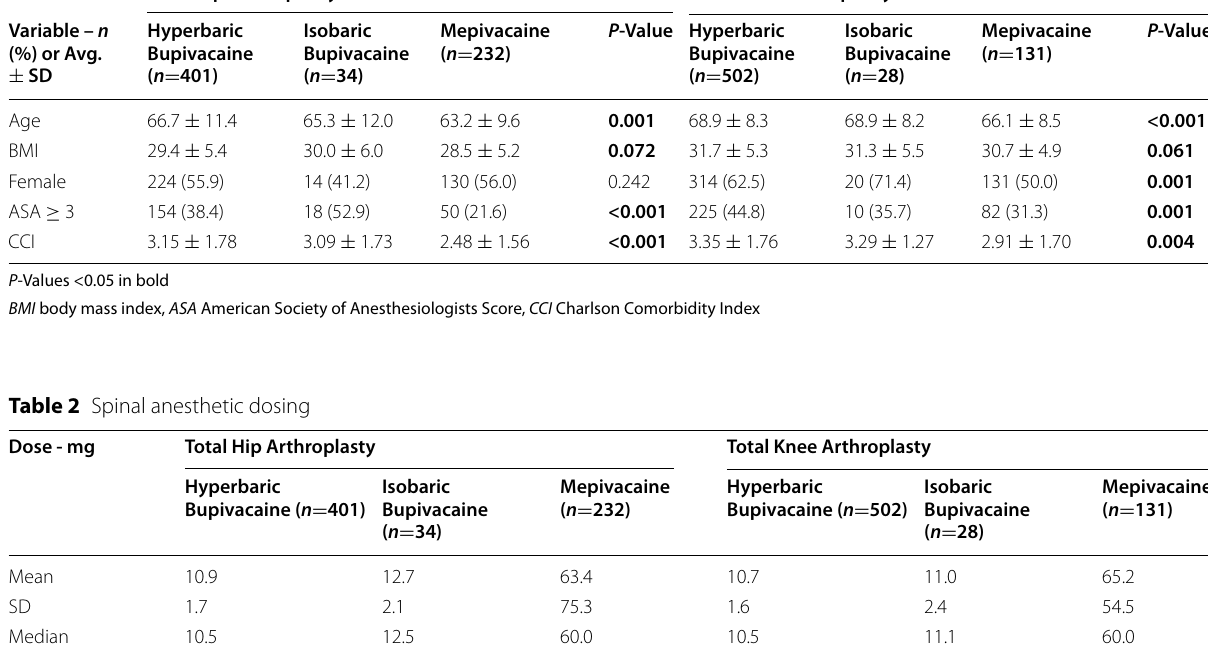
Table 1 Patient demographics and comorbidities Total Hip Arthroplasty Variable – n (%) or Avg.